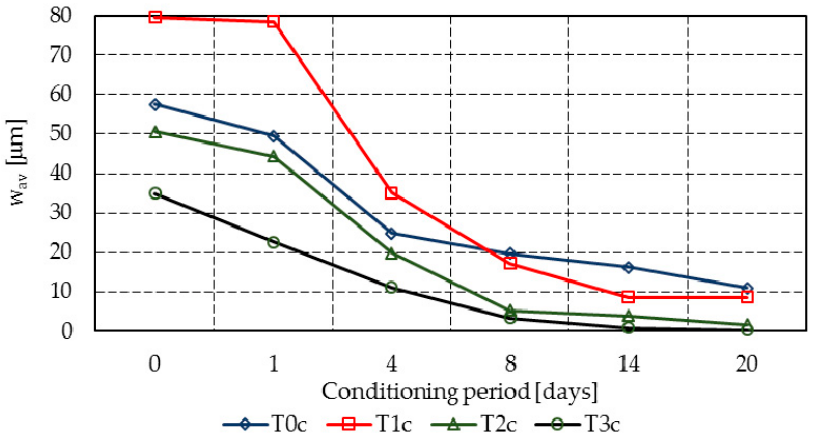
Figure 5. Mean crack progress in mixtures T0c–T3c. Mixtures T3r and T3c entirely or almost entirely filled the cracks within 14 days, at which point the registered closure rates were 98.9% and 97.3%, respectively. However, at 20 days, T3r reached 99.6% and T3c reached 99.3%, while the reference mixes T0r and T0c presented closure rates of 88.6% and 80.8%, respectively (see Figure 6 compared to Figure 7).